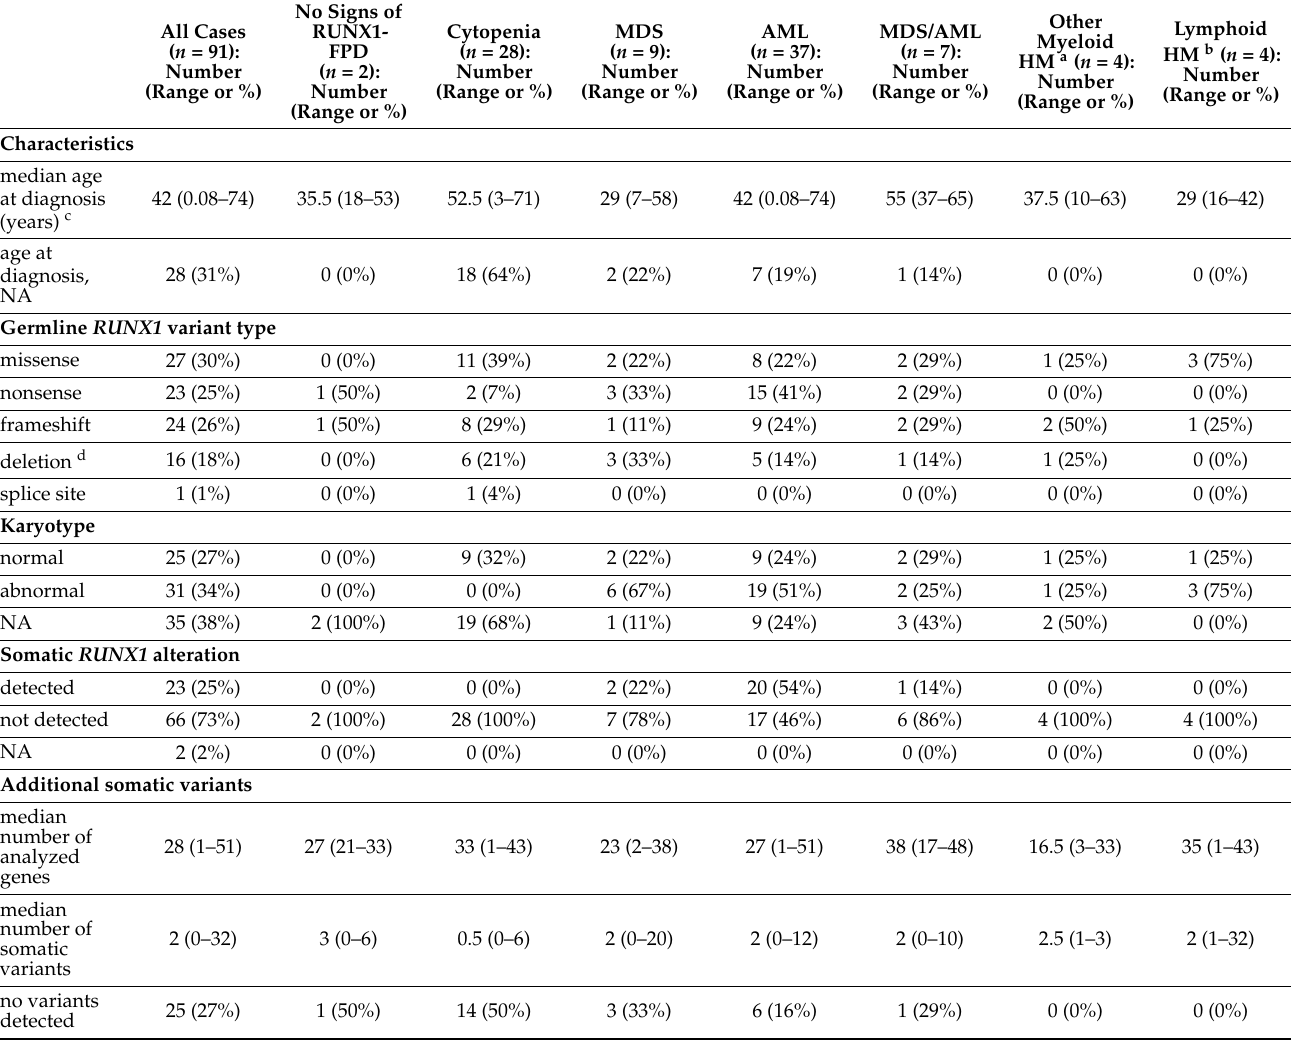
Table 1. Comparison of clinical and genetic characteristics of the retrospectively reviewed cohort of 91 patients with